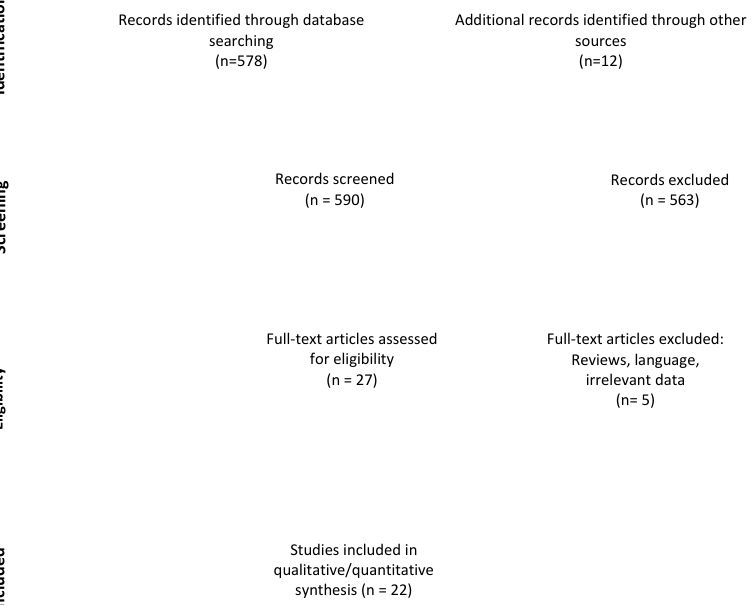
Figure 1. Preferred Reporting Items for Systematic reviews and Meta-Analyses 2015 (PRISMA-P) flow-chart and search strategy.